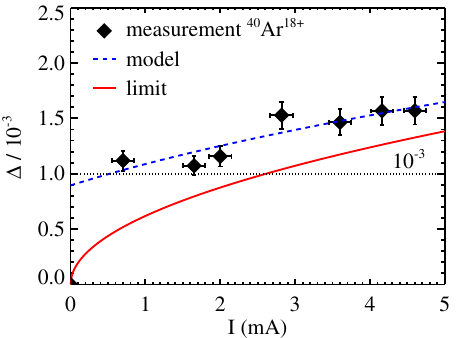
FIG. 4. The final total momentum spread of the debunched, coasting beam in the SIS for 40 Ar 18 þ ions as a function of the injected UNILAC current (diamonds). The error bars represent the current fluctuations of the injected beam and the fitting errors to the longitudinal Schottky signal. The measured momentum spread lies above the limit determined by the rf bucket (black dotted line). Equation (16) (blue dashed line) reproduces the measured data very well. For UNILAC currents exceeding ¼ ð (cid:7)p=p Þ I (cid:2) 2 : 5 mA , the lower limit of momentum spread given by the 0 m m Eq. (17) (red continuous line) lies above the tolerable